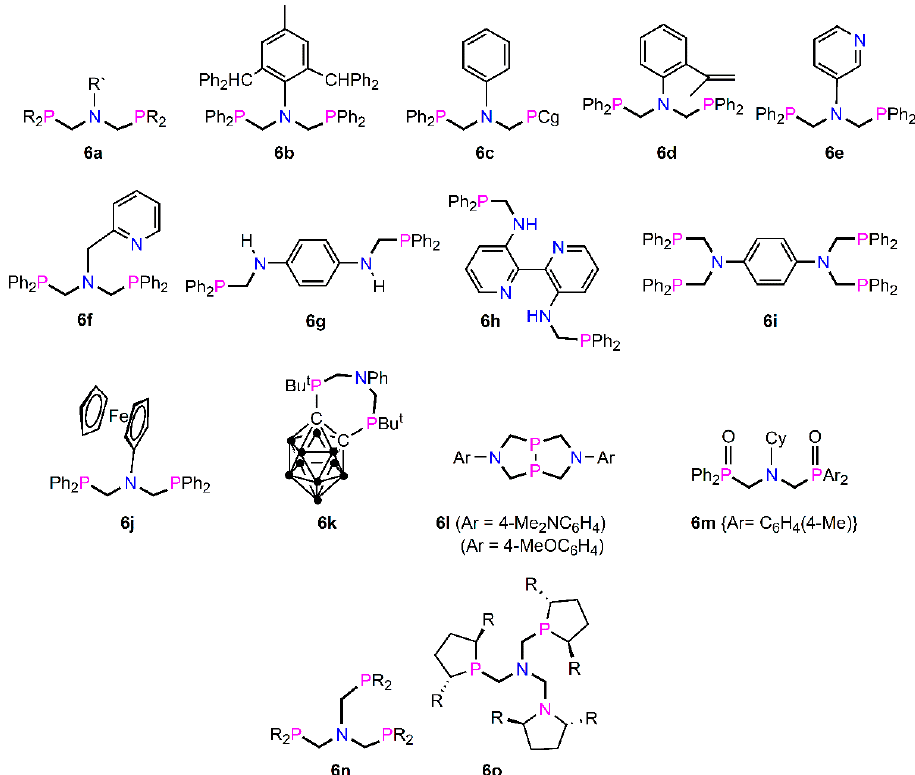
Figure 8. Selected examples of bis- and tris-aminomethylphosphines.